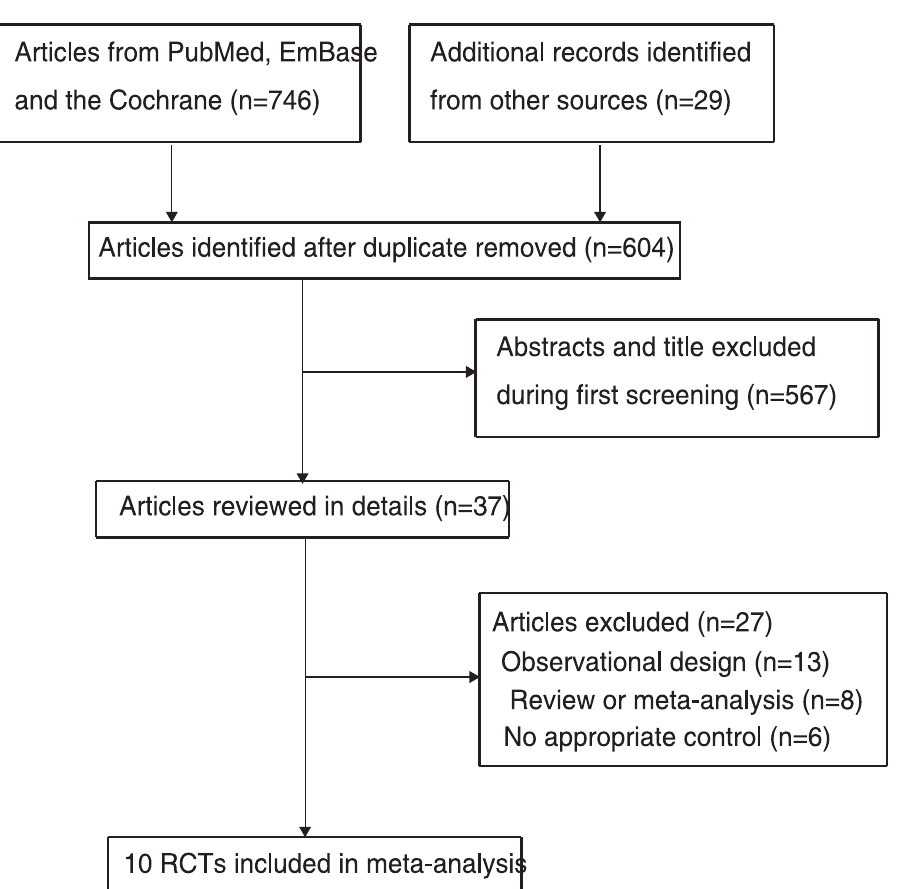
Fig 1. PRISMA flowchart for the study selection